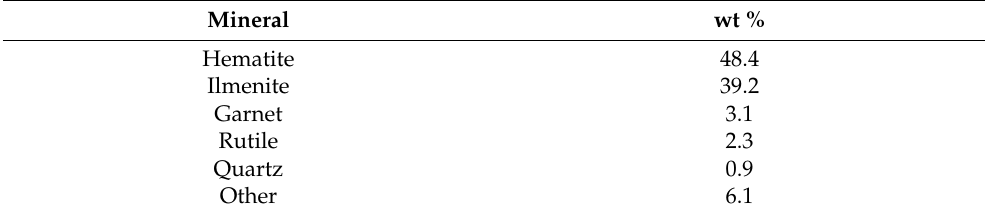
Table 6. Mineralogical composition of garnet concentrate from MS 3A. Mineral wt % Garnet 94.0 Tourmaline Quartz